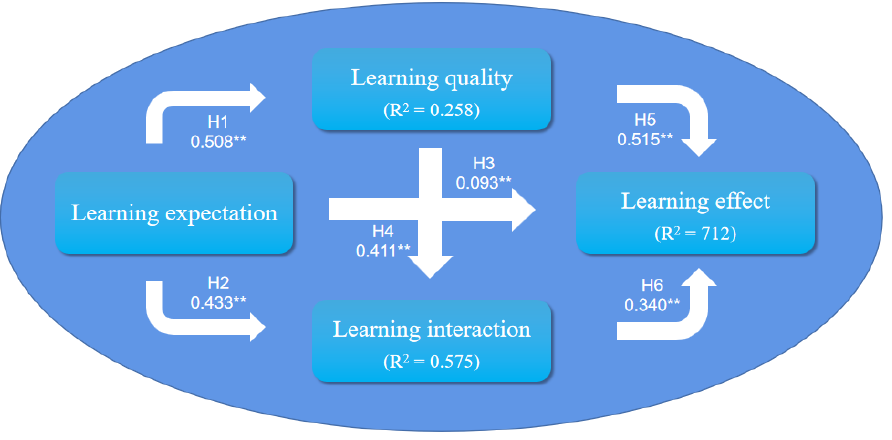
Figure 3. Structural model and R 2 values.( significant at ** p < 0.01).